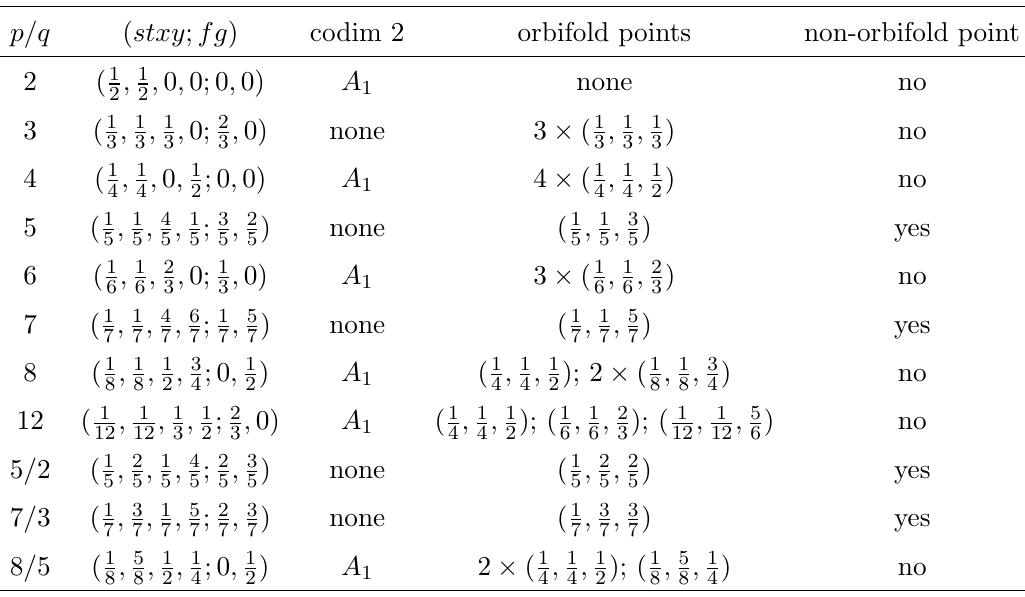
Table 2 . Singularity